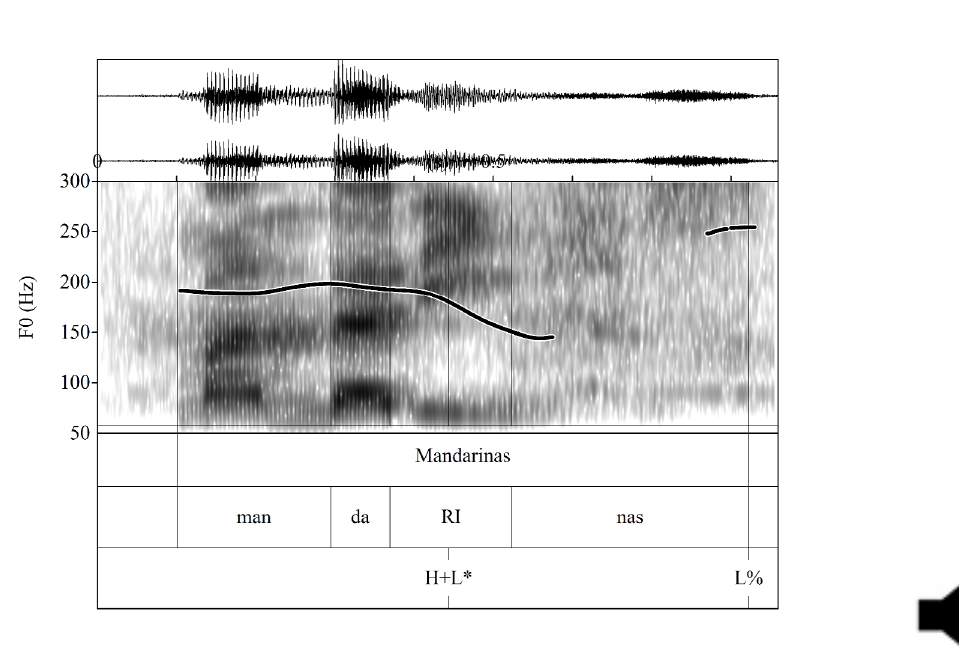
Figure 4 (Participant 13): Waveform and F0 trace for the broad focus statement Mandarinas ‘Tangerines’ with a nuclear pitch accent produced with H+L* followed by an L% boundary